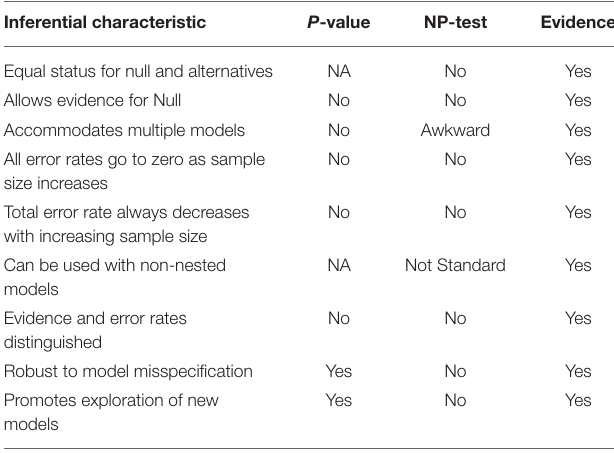
TABLE 1 | A comparison of inferential characteristics between Fisherian significance testing ( P -values sensu stricto ), Neyman-Pearson hypothesis tests (including P -values for likelihood ratios) and evidential